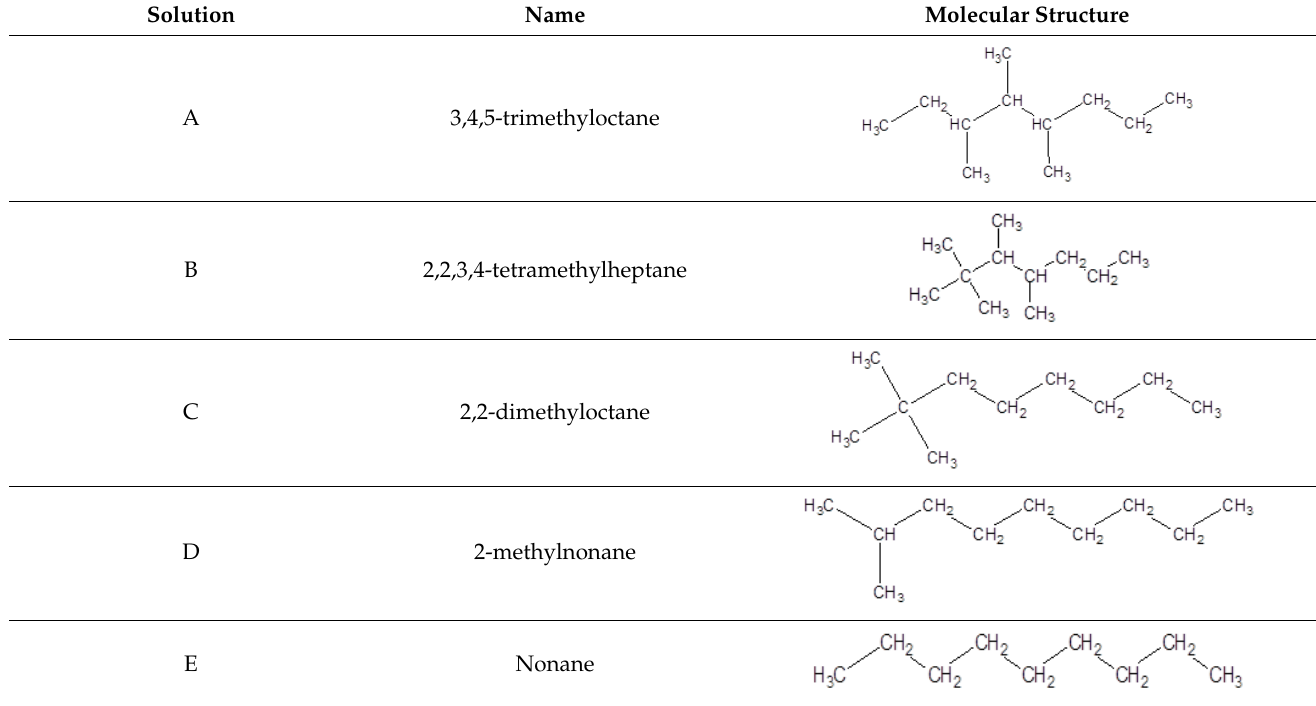
Table 6. Product specifications of designed product.